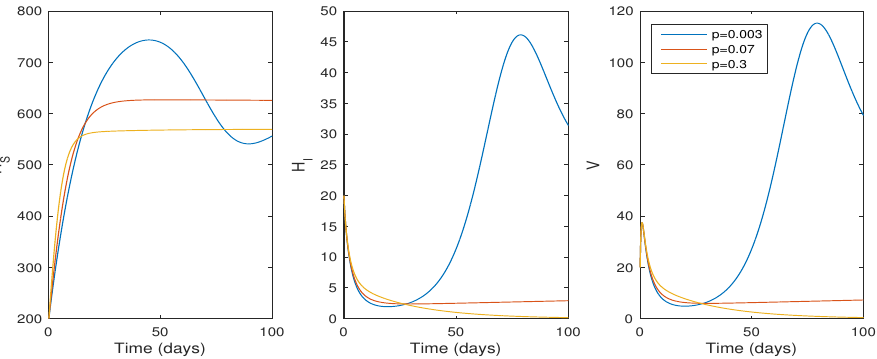
Figure 4. The effect of infection rate ( p ) on system trajectories with p = 0.003, 0.07 and 0.3; time t in days; and the values of the parameters as given in Table